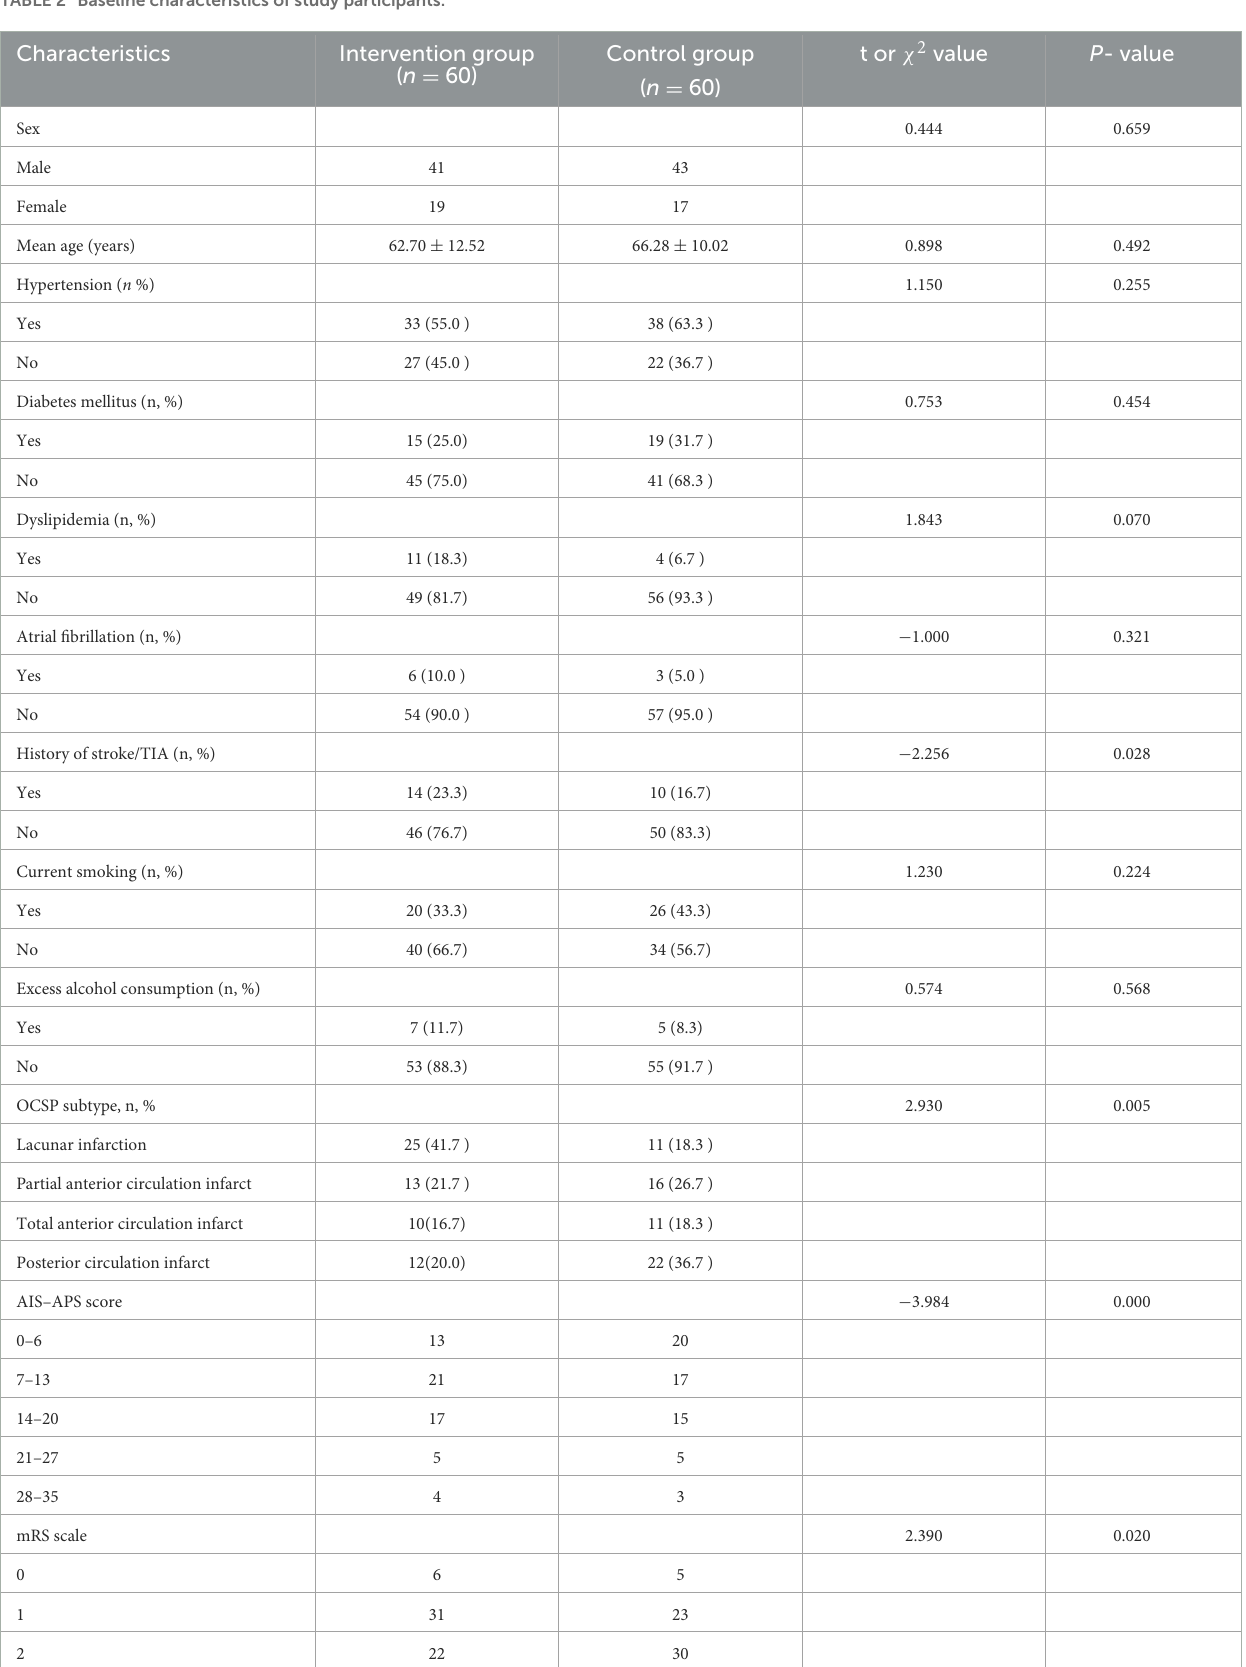
TABLE 2 Baseline characteristics of study